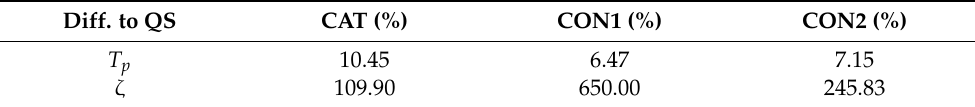
Figure 18. Comparative time histories of mooring tension obtained from decay tests in surge. Table 10. Comparative changes of each system’s natural period, T p , and of each system’s percentage of critical damping, ζ , caused by the presence of the mooring systems obtained from decay tests in